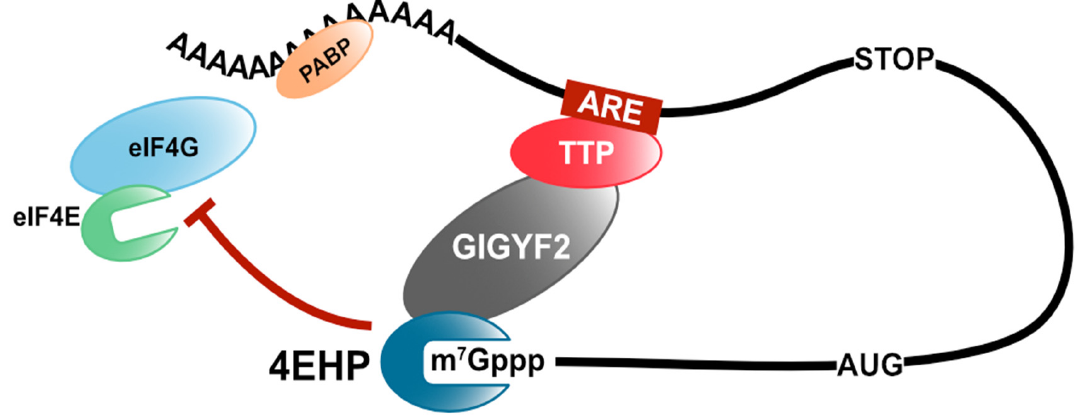
Figure 2. TTP-mediated translation repression. TTP recruits the GIGYF2/4EHP complex to the target mRNA and inhibits the assembly of eIF4F.